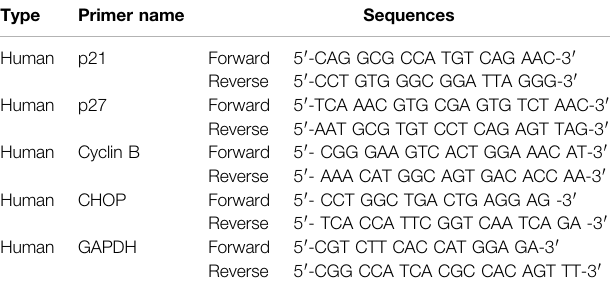
TABLE 1 | RT-PCR primer sequences list.